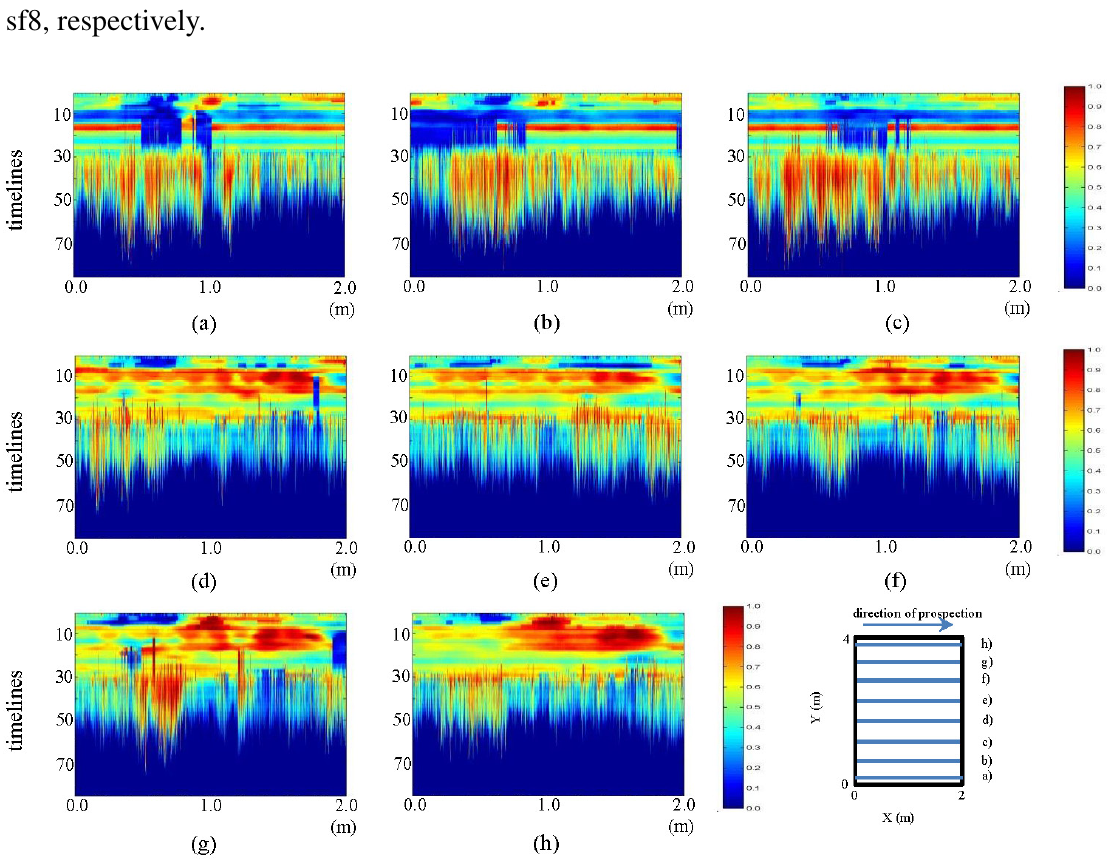
Figure 24. Horizontal profiles: pre-processed images. ( a – h ) are profiles sf1 a sf8,